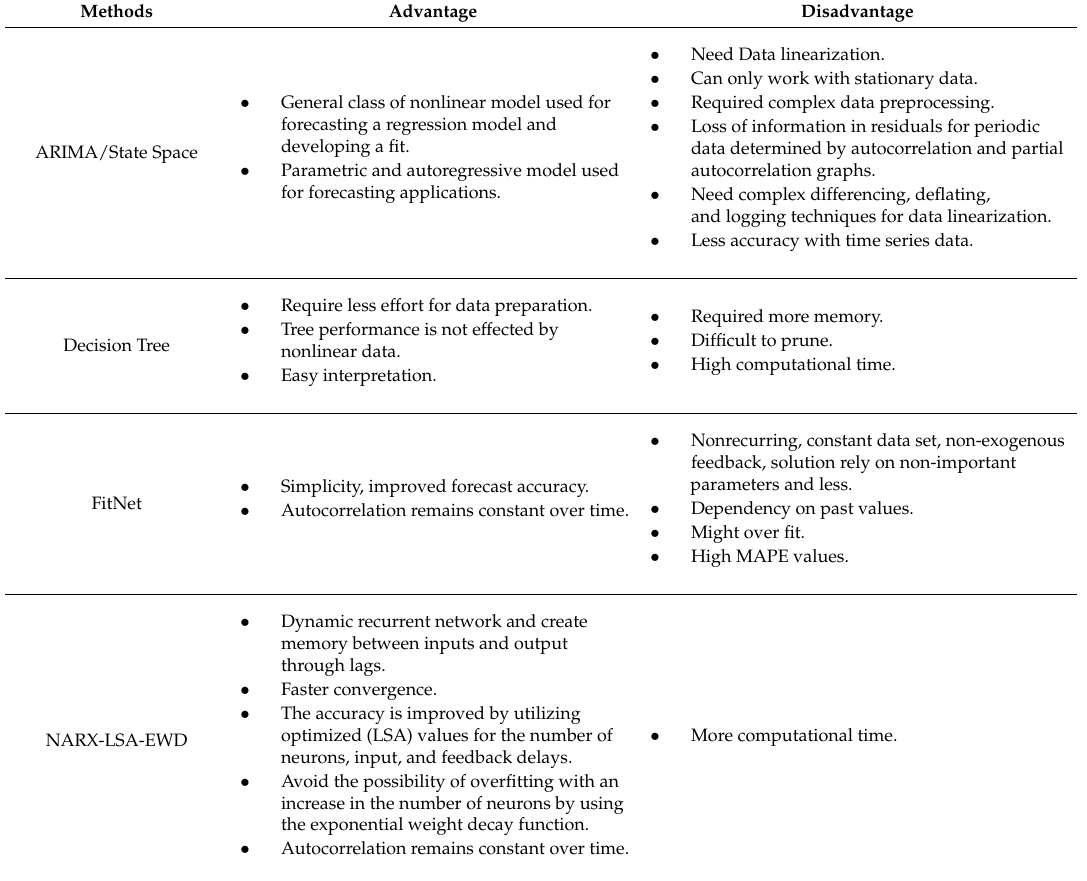
Figure 11. ( a ) Actual load vs model prediction (1-Kanal), ( b ) actual load vs model prediction (10-Marla), ( c ) actual load Vs model prediction (7-Marla), ( d ) actual load Vs model prediction (5-Marla). Table 2. Advantage and disadvantage for forecasting Table 1. Model comparison statistics.